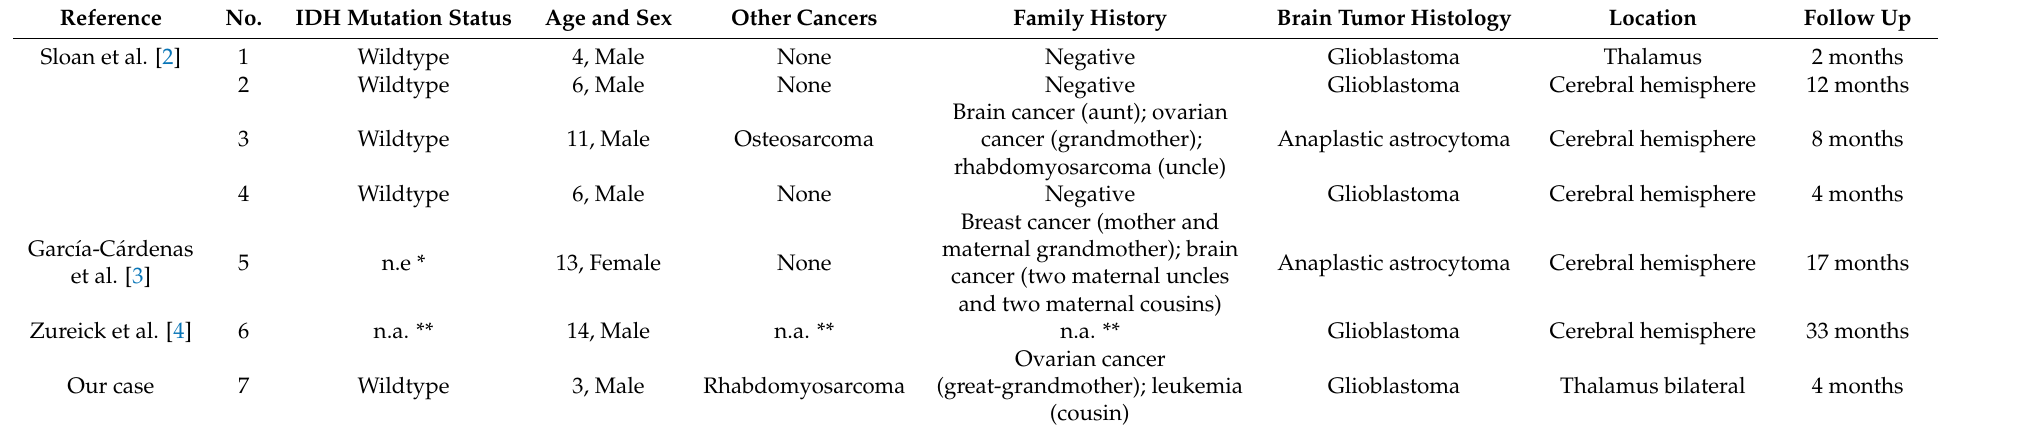
Table 1. High grade gliomas in patients with Li-Fraumeni syndrome: reported cases in the